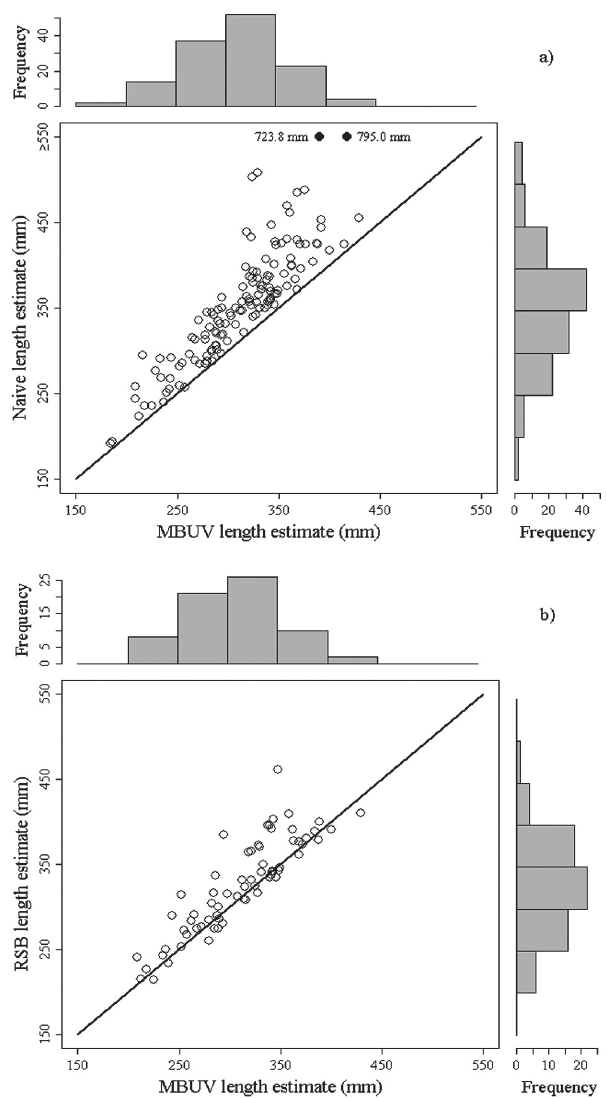
Fig. 5. Scatter plots with marginal histograms showing fish length estimates (mm) obtained with (a) Mirrored baited underwater video system (MBUV) and naive methods ( n = 132), and with (b) MBUV and Reference scale at the bait level (RSB) methods ( n = 67), in five Submarine Parks within Golfo Nuevo. Solid circles in (a) represent truncated lengths (>550 mm). The corresponding naive estimates for the truncated lengths are indicated next to the circles. Solid black lines represent the regression 1:1 in both